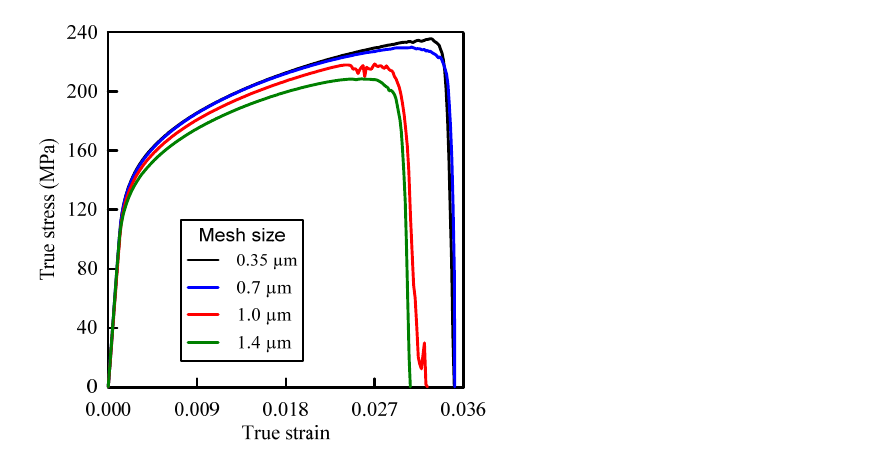
Figure 2. Tensile true stress–strain curves for A359/SiC composite using different FE mesh sizes (PS = 10 µm, 10% volume fraction (VF)). Table 1. Mesh size effect on the failure strain and ultimate tensile strength.